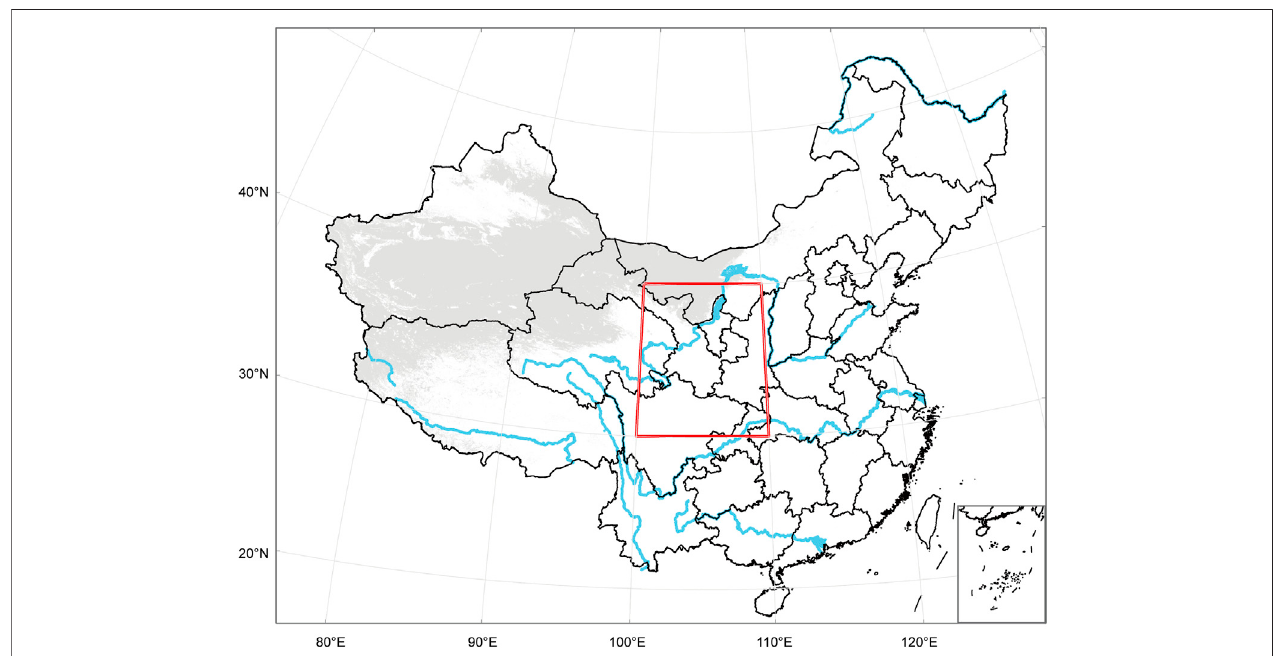
FIGURE 1 | The range of the eastern region of eastern Northwest